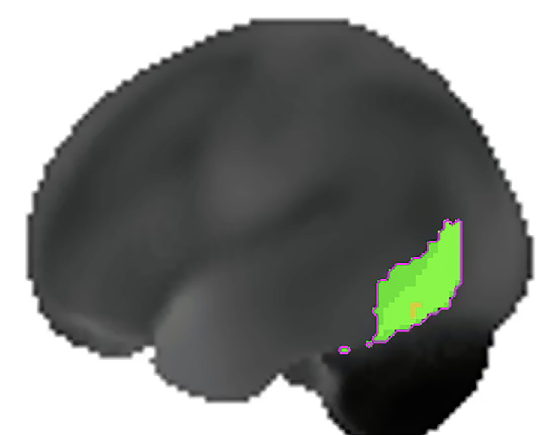
Figure 4. The largest cluster ( P = 0.93) identified in the population template using MIMneuro ® cluster analysis tools spanned portions of the left temporal and occipital lobes. This image depicts the left hemisphere surface projection of the population template with the cluster highlighted in